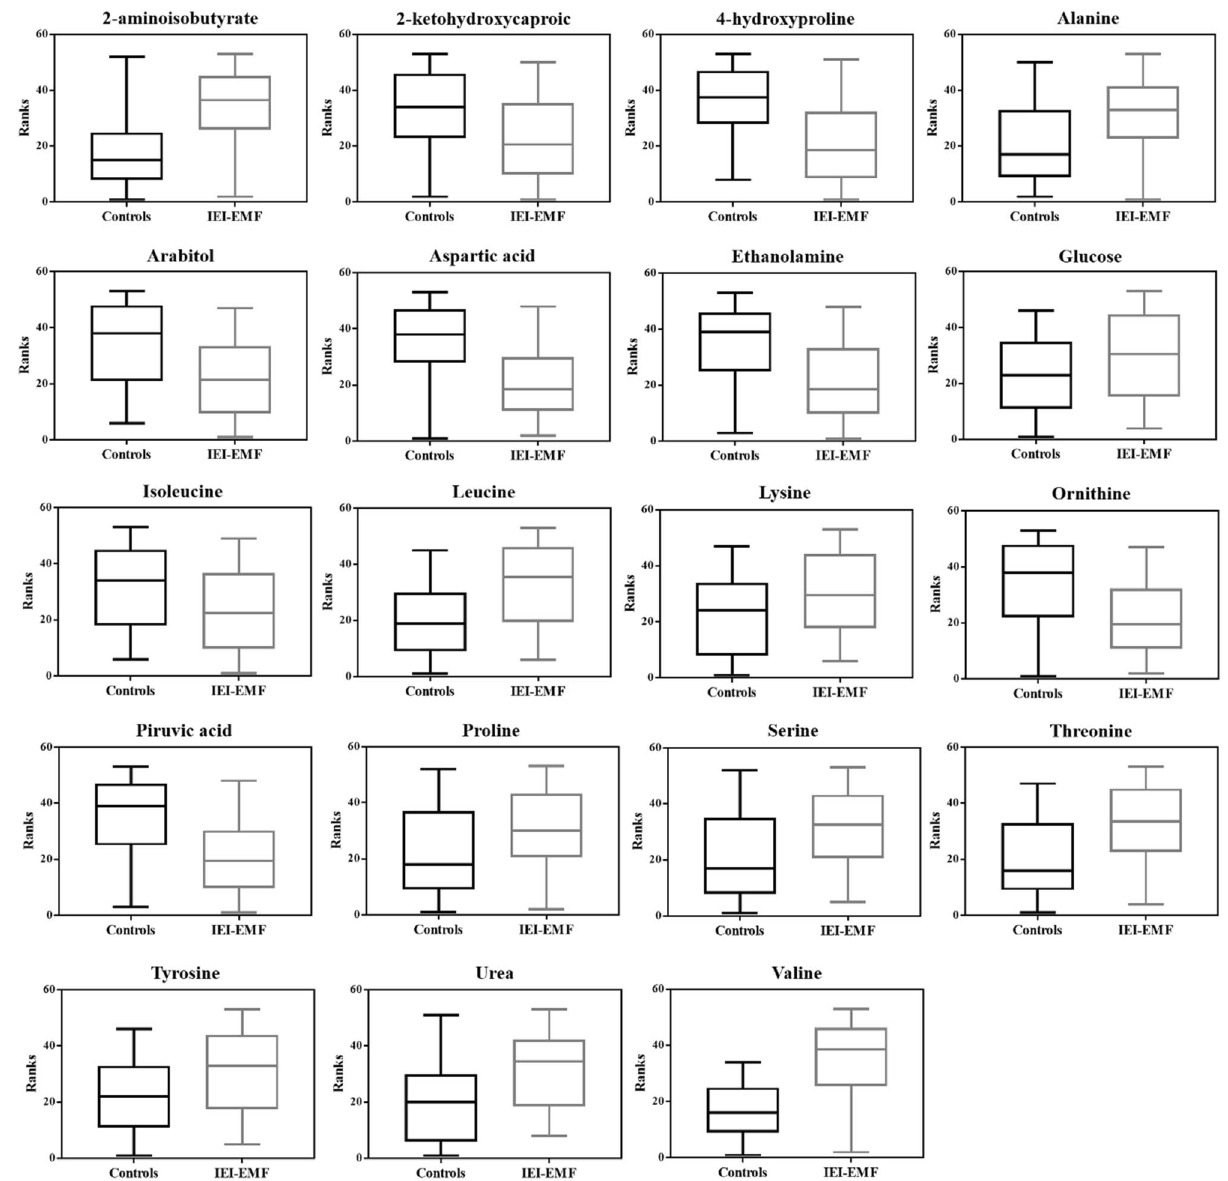
Figure 2. Statistically significant metabolites in IEI-EMF subjects compared to controls. The resulted metabolites are shown and expressed in the graphs y-axis as ranks (data transformation in which numerical or ordinal values are replaced by their rank when the data are